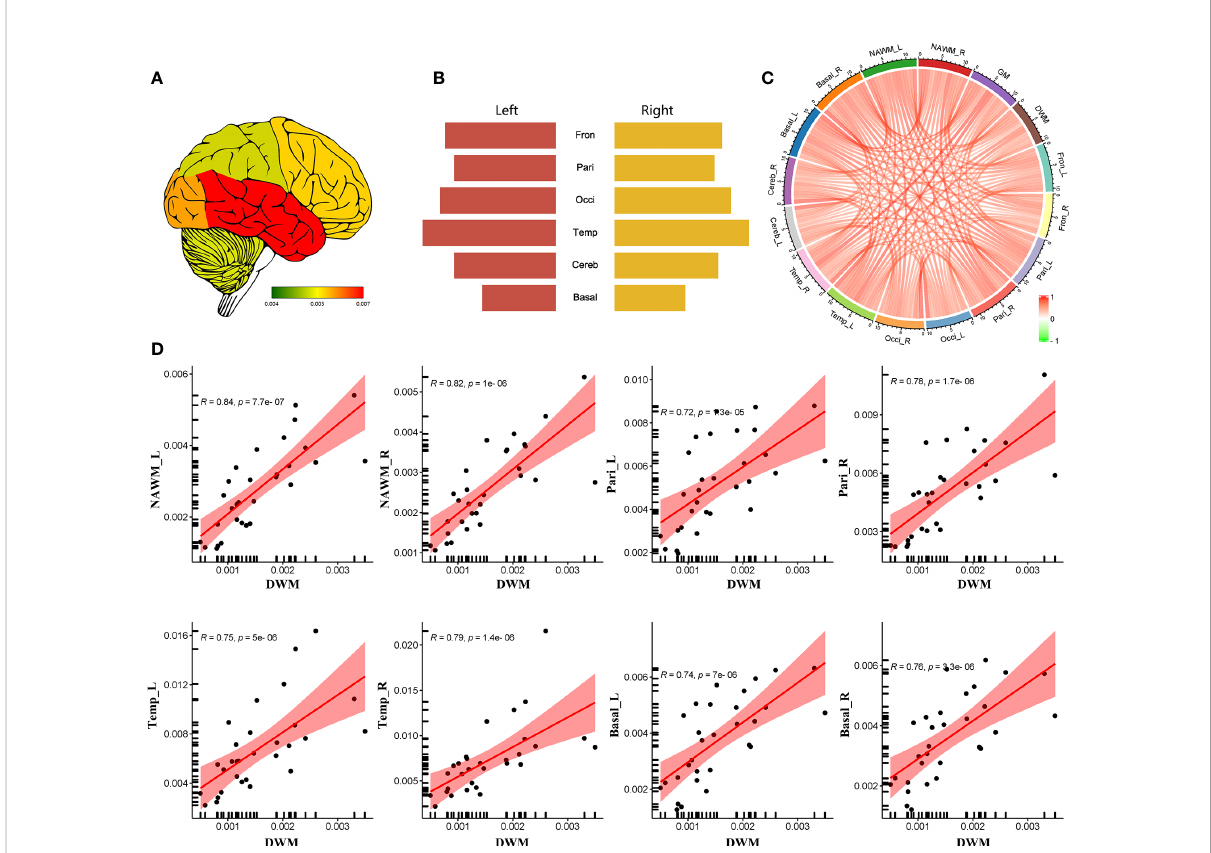
FIGURE 1 The regional distribution of CBF in MS patients. (A) CSF heatmap of different brain regions. (B) Comparison of CBF in different brain regions. (C) Correlation analysis among different regions. (D) Signi fi cantly positive correlation of CBF between DWM and some brain region (NAWM, parietal lobes, temporal lobes and basal ganglia). (Fron_L, left frontal lobe; Fron_R, right frontal lobe; Pari_L, left parietal lobe; Pari_R, right parietal lobe; Occi_L, left occipital lobe; Occi_R, right occipital lobe; Temp_L, left temporal lobe; Temp_R, right temporal lobe; Cereb_L, left cerebellum; Cereb_R, right cerebellum; Basal_L, left basal ganglia; Basal_R, right basal ganglia; NAWM_L, left normal-appearing white matter; NAWM_R, right normal-appearing white matter; DWM, damaged white